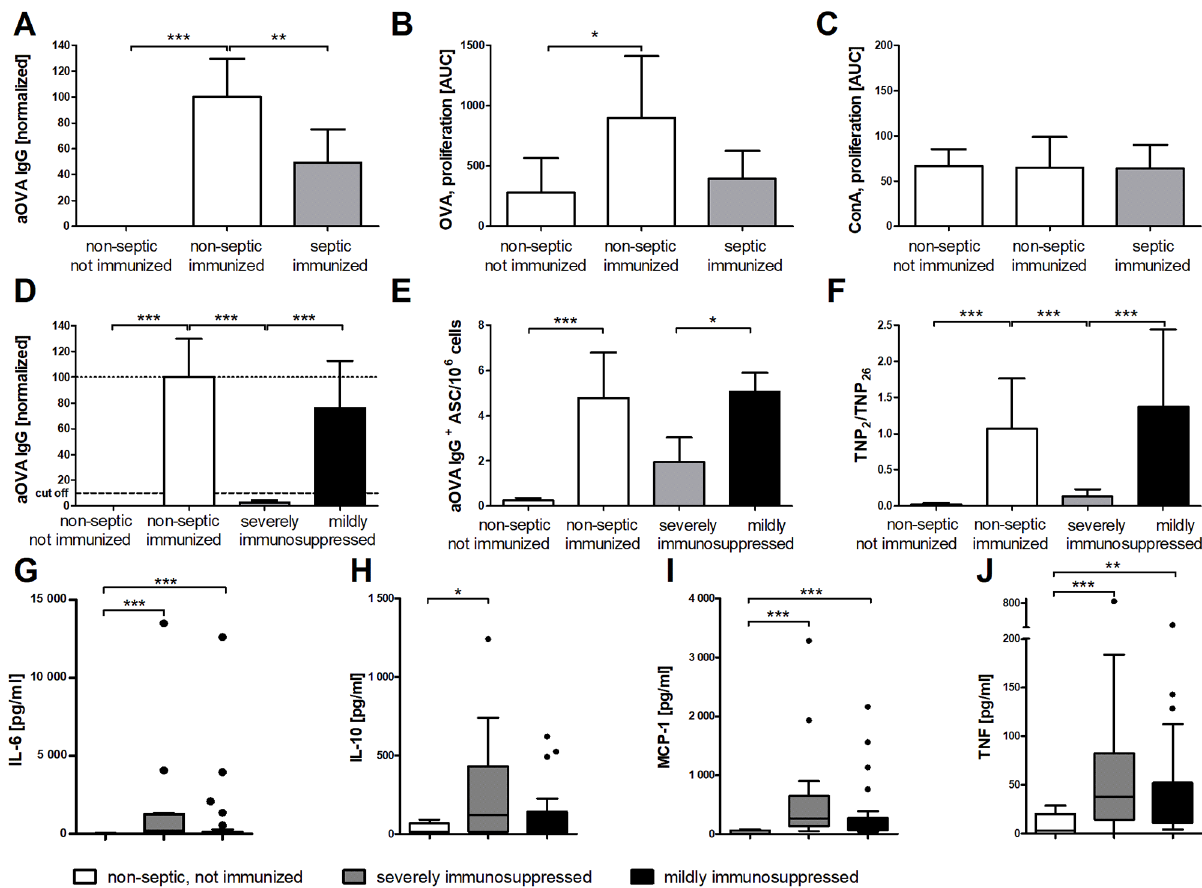
Fig 1. Suppression of the adaptive immune response after sepsis induction. Sepsis was induced in C57BL/6 mice, and on day 7, the animals were immunized intraperitoneally with TNP-OVA/OVA in alum (n = 47). Non-septic, not immunized animals (n = 32) and non-septic immunized animals (n = 25) served as controls. The antigen-specific immune response was determined 14 days after the immunization by measuring the serum concentration of anti-OVA IgG by ELISA. (A) The relative concentrations of OVA-specific IgG antibodies in serum normalized to a standard serum are shown (arbitrary units, AU). (B) The proliferative response to restimulation with OVA was measured by thymidine incorporation ex vivo . (C) The proliferative response to the mitogen concanavalin A (ConA) served as control. (D) Animals that had been immunized post-sepsis were divided into two groups: severely immunosuppressed mice (n = 17) had OVA-specific IgG concentrations below 10% of control values, while mildly immunosuppressed animals (n = 30) had serum concentrations greater than or equal to 10%. (E) Numbers of OVA-specific IgG-secreting cells in the bone marrow were determined in an ELISpot assay. (F) The relative antibody affinity of TNP-specific IgG was measured as binding to slightly haptenized TNP-BSA in comparison to highly haptenized TNP-BSA in an ELISA (adapted from [34]). (G-J) Blood was drawn 24 h after sepsis induction and cytokine concentrations of IL-6 (G), IL-10 (H), MCP-1 (I), and TNF (J) were quantified in the sera. Severely (n = 15) and mildly immunosuppressed (n = 29) animals are compared with non-septic, not immunized controls (n = 12). In the panels A-F means and 95% confidence intervals are shown. In the panels G-J box plots depict medians and quartiles. Group differences were tested for significance with the Kruskal-Wallis test and Dunn’s multiple comparison for selected pairs. Results were pooled from five separate experiments. (cid:3)(cid:3)(cid:3) P < 0.001; (cid:3)(cid:3) P < 0.01; (cid:3) P <